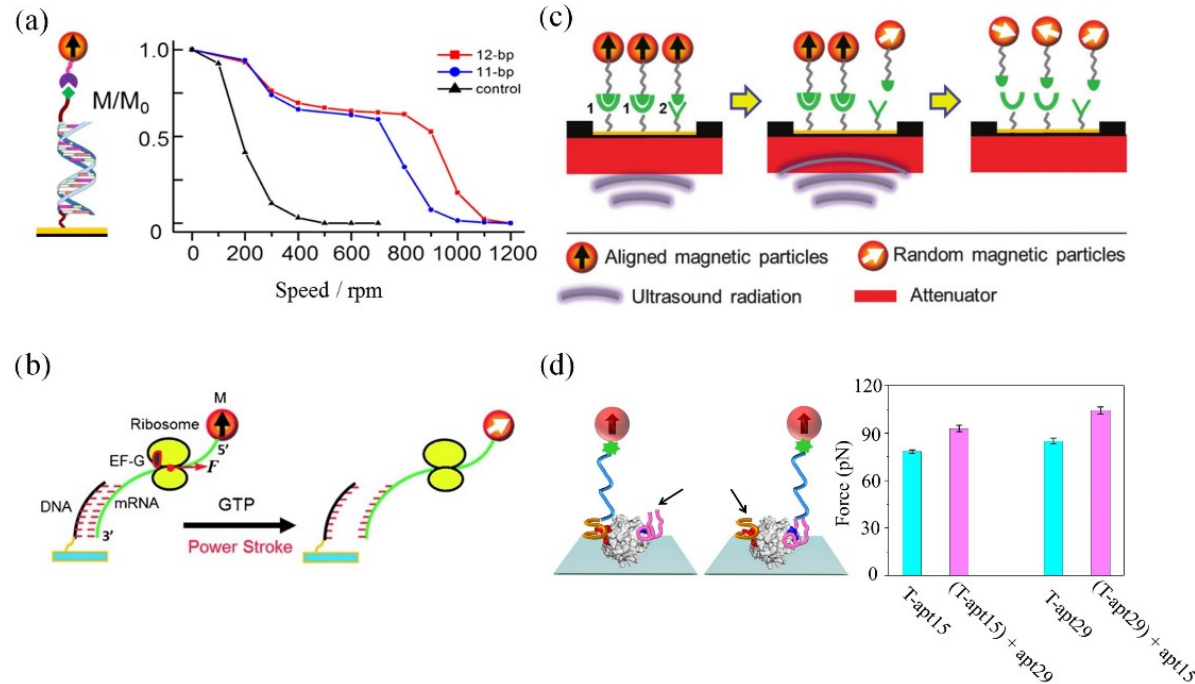
Figure 4. ( a ) FIRMS spectra of the interaction of DNA oligomers [28]. Reproduced with permission from the American Chemical Society. ( b ) Schematic of measuring the EF-G power stroke with internal force references [29]. Reproduced with permission from Wiley. ( c ) Schematic of the ultrasound radiation force-based FIRMS technique [34]. Reproduced with permission from the Royal Society of Chemistry. ( d ) Differential binding force directly proving the through-bond effects in monovalent binding complexes [39]. Reproduced with permission from Wiley.